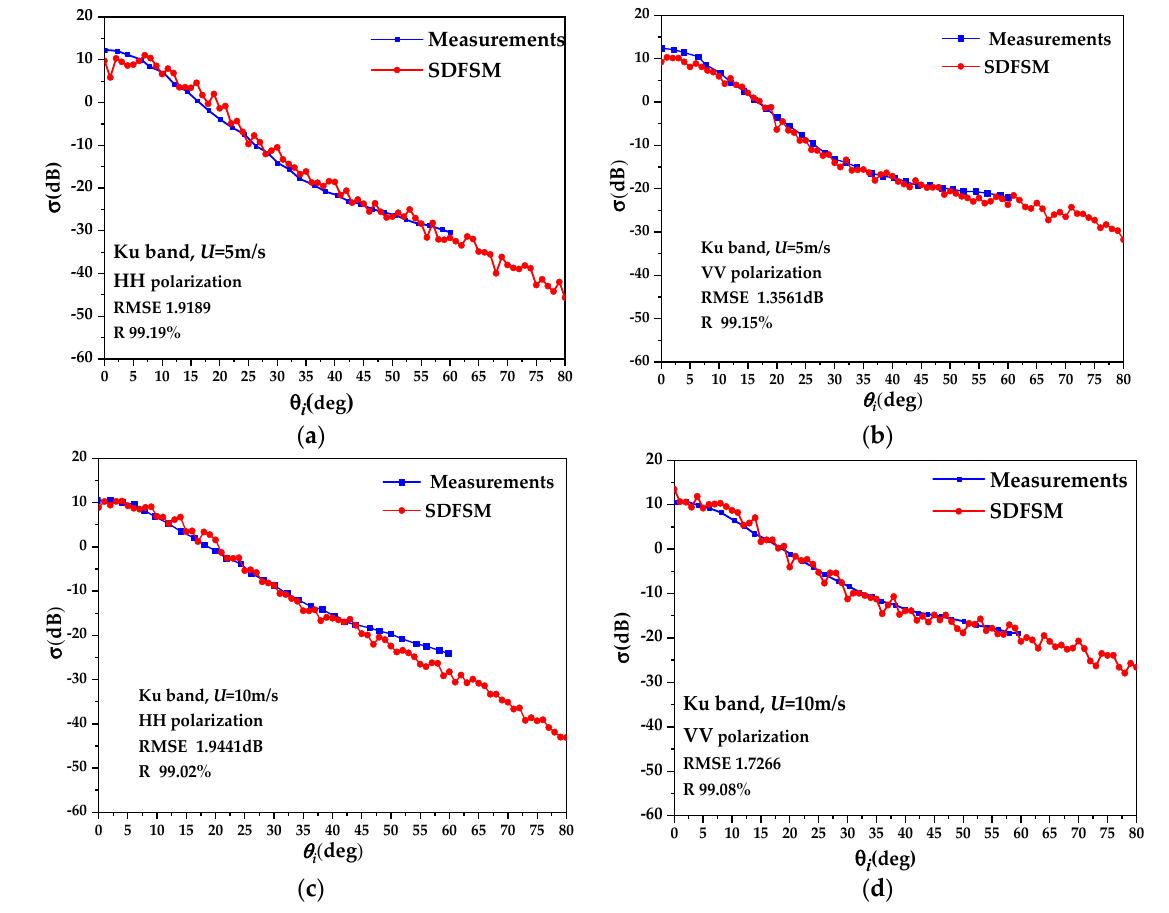
Figure 3. Comparison of backscattering coefficient from 3D sea surface between the SDFSM and measurements. ( a ) U = 5 m / s , HH polarization. ( b ) U = 5 m / s , VV polarization. ( c ) U = 10 m / s , HH polarization. ( d ) U = 10 m / s , VV